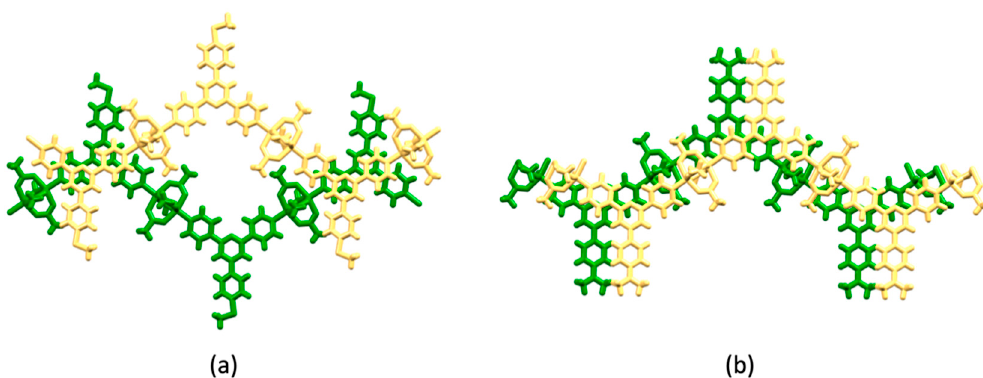
Figure 16. In [Zn 2 ( μ‐ OAc) 4 (4’ ‐ X ‐ 4,2’:6’,4” ‐ tpy)] n type 1D ‐ zigzag polymers, face ‐ to ‐ face π‐ stacking occurs between chains, and the arrangement is influenced by the X substituent. For example: ( a ) [Zn 2 ( µ -OAc) 4 ( 28 )] n (CSD refcode CUXCUU), and and the arrangement is influenced by the X substituent. For example: (a) [Zn 2 ( μ‐ OAc) 4 ( 28 )] n (CSD refcode CUXCUU), and (b) [Zn 2 ( μ‐ OAc) 4 ( 29 )] n (refcode QOTROI). Note that the mode of packing into 2D ‐ sheets is analogous in both compounds ( b ) [Zn 2 ( µ -OAc) 4 ( 29 )] n (refcode QOTROI). Note that the mode of packing into 2D-sheets is analogous in both compounds (see Figure 15). (see Figure